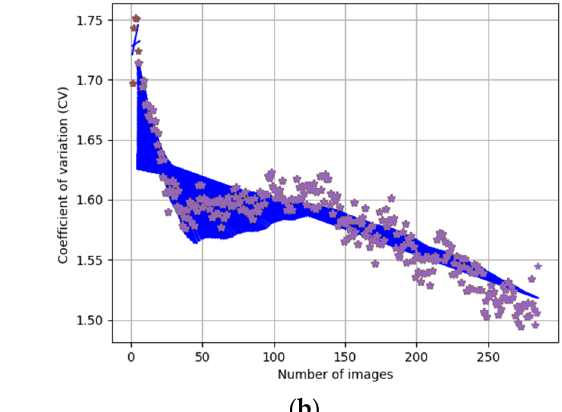
time. ( b ) Modeling CV using a linear regression to compute and predict the parameter for adaptive